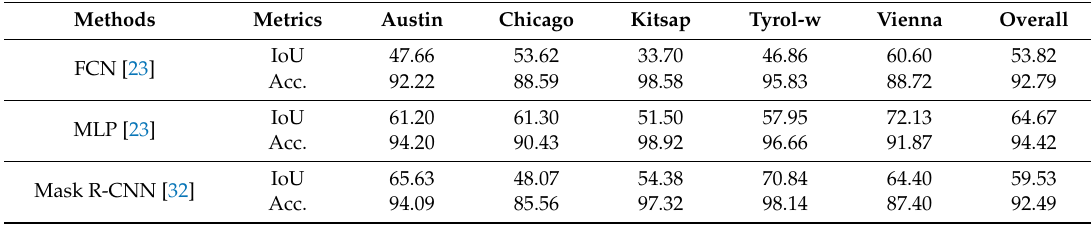
Table 2. Experimental results on Inria aerial image labeling